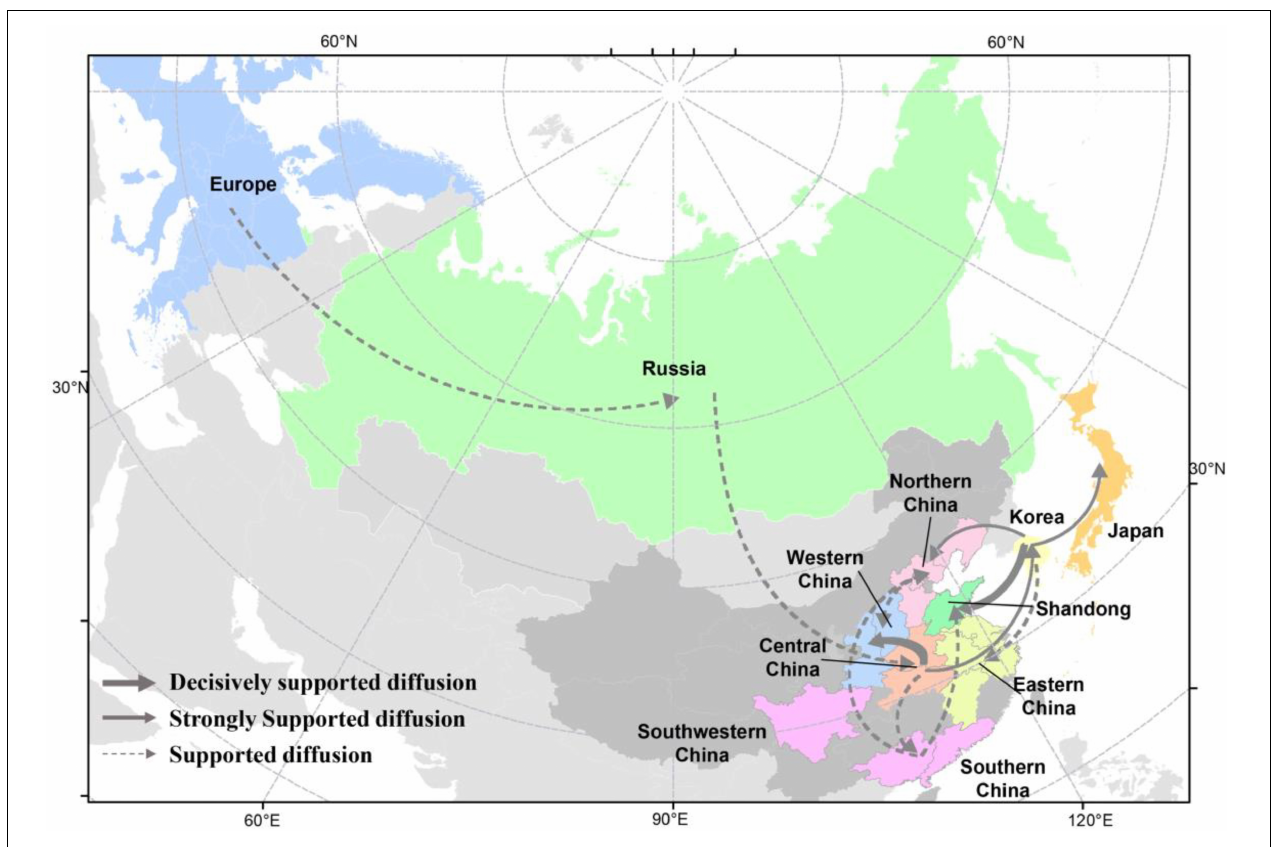
FIGURE 6 | Spatial diffusion of the HA gene segment of clade 2.3.4.4b H5 subtype viruses during 2020–2021. The red dots indicate the sampling sites of poultry in China, and the blue dots indicate the sampling sites of wild birds in China. Curves show the among-province or country virus lineage transitions statistically supported with Bayes factor > 3 for H5 subtype influenza viruses. The strongly bold gray arrow indicates decisively supported diffusions (BF < 100,000); bold gray arrows, strongly supported diffusions (100 ≤ BF < 10,000); and solid gray arrows, supported diffusions (10 ≤ BF < 100). The map was designed using R and ArcGIS Desktop 10.4 software (http://www.esri.com/software/arcgis/arcgis-for-desktop/).